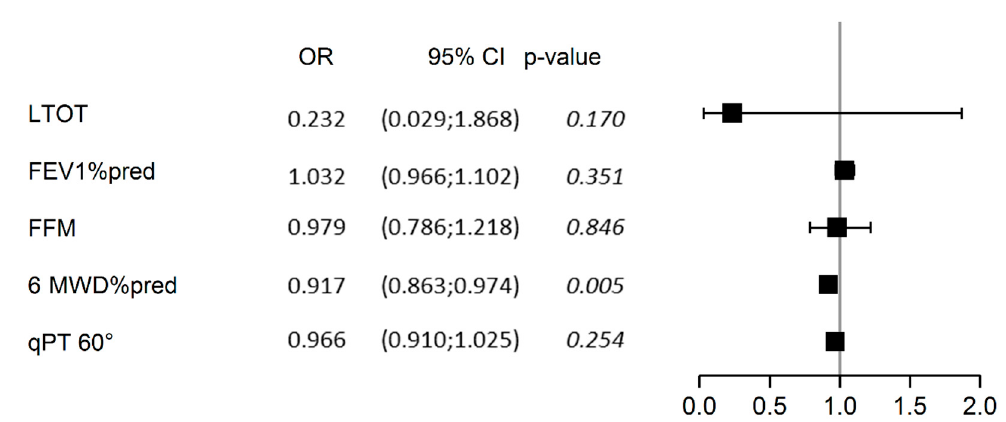
Figure 2. Forest plot of the multivariable analysis of determinants of past falls. The analysis was adjusted for gender, age, and BMI, all of which were non-significant determinants, and which were therefore omitted from the graph for clarity. LTOT, treatment with long-term oxygen therapy; FFM, fat-free mass (kg); 6MWD%pred, 6-min walking distance expressed as a percentage of the predicted value; qPT 60°, isokinetic quadriceps peak torque (PT) at concentric 60°.